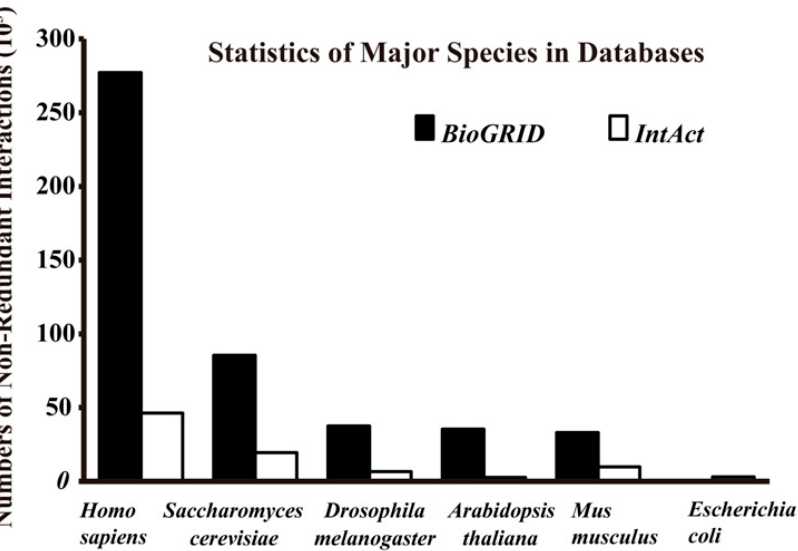
Figure 2. Total non-redundant interactions of major species in BioGRID (Version 3.4.140, September 2016) and IntAct (September 2016).